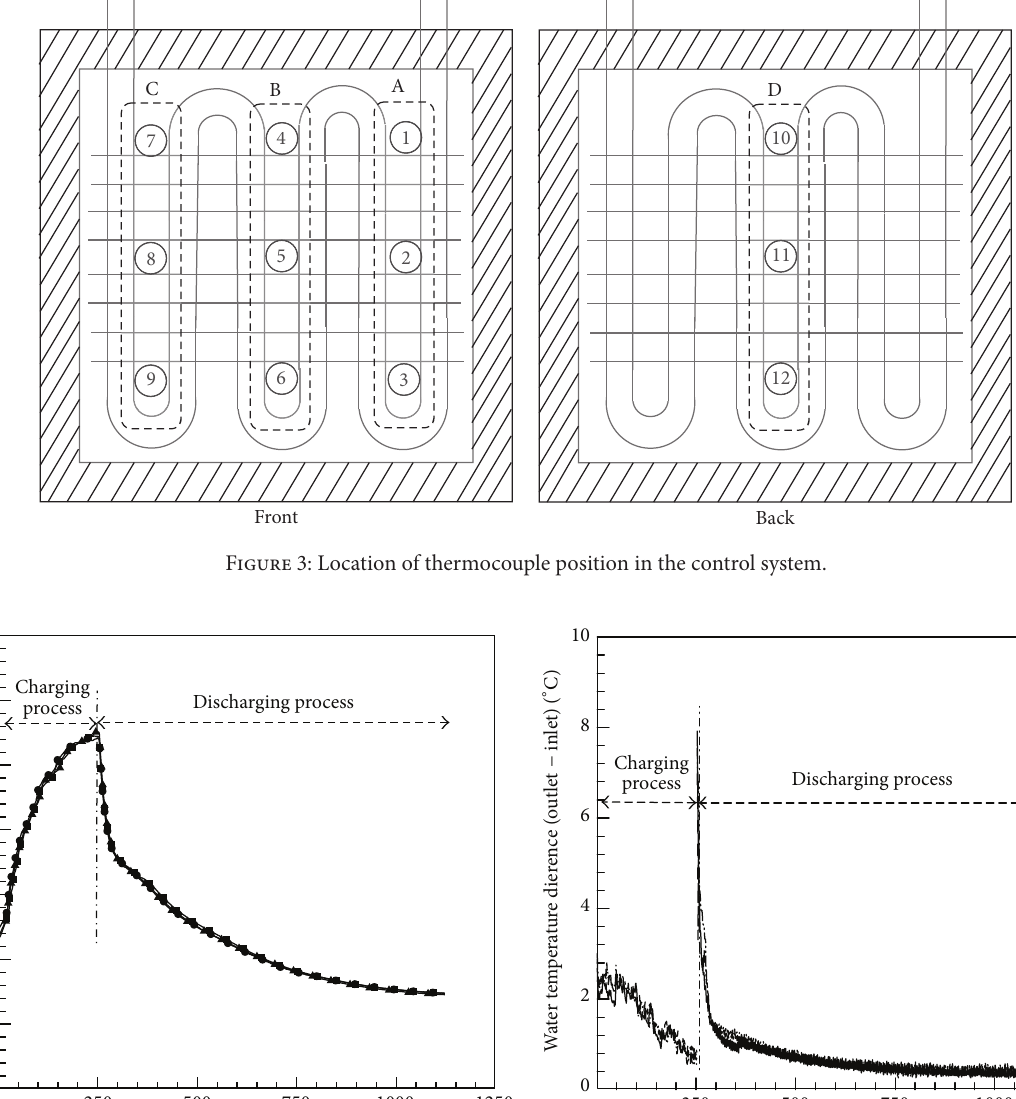
equilibrium with the conditioned lab temperature (21–24 ∘